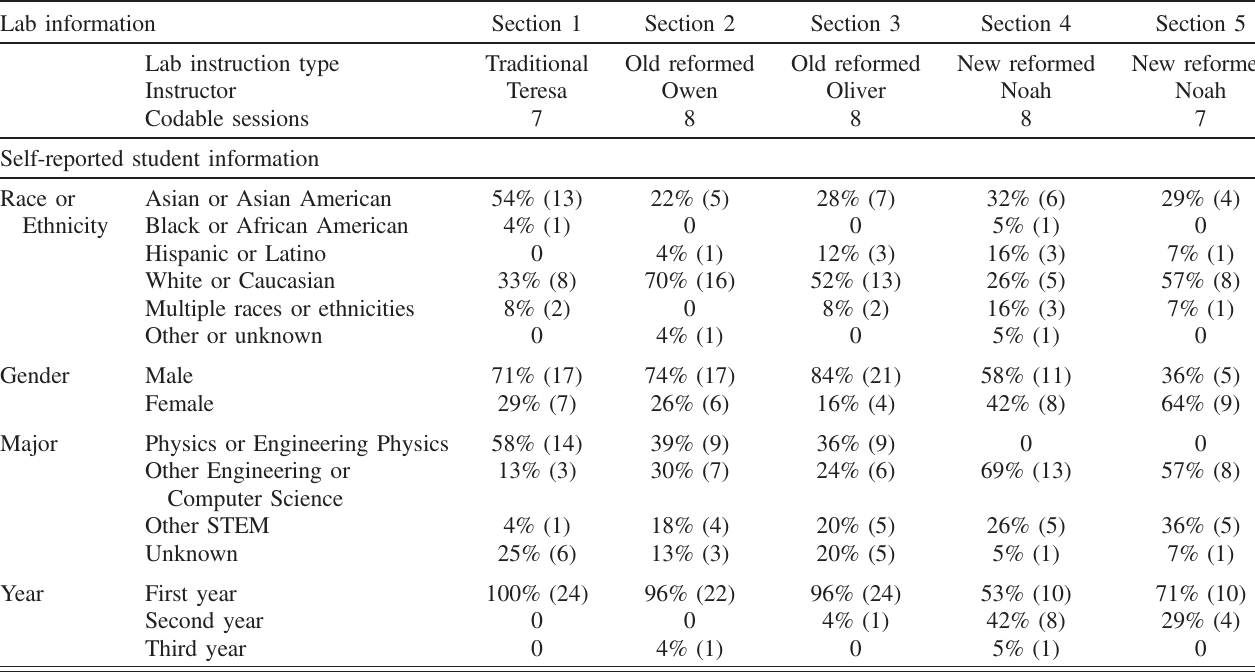
TABLE I. Summary of information about the lab type, instructors, and number of codable sessions, as well as the self-reported major and year of students in each lab section. Numbers in parentheses are the N values corresponding to the percentages.